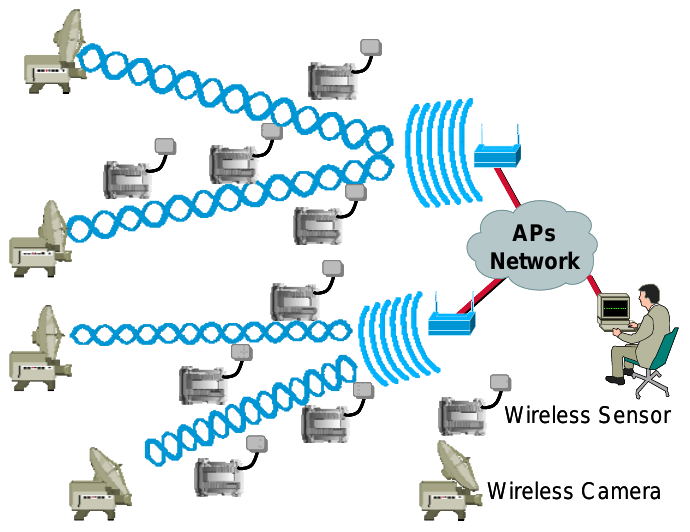
Figure 2. Fire detection and verification design